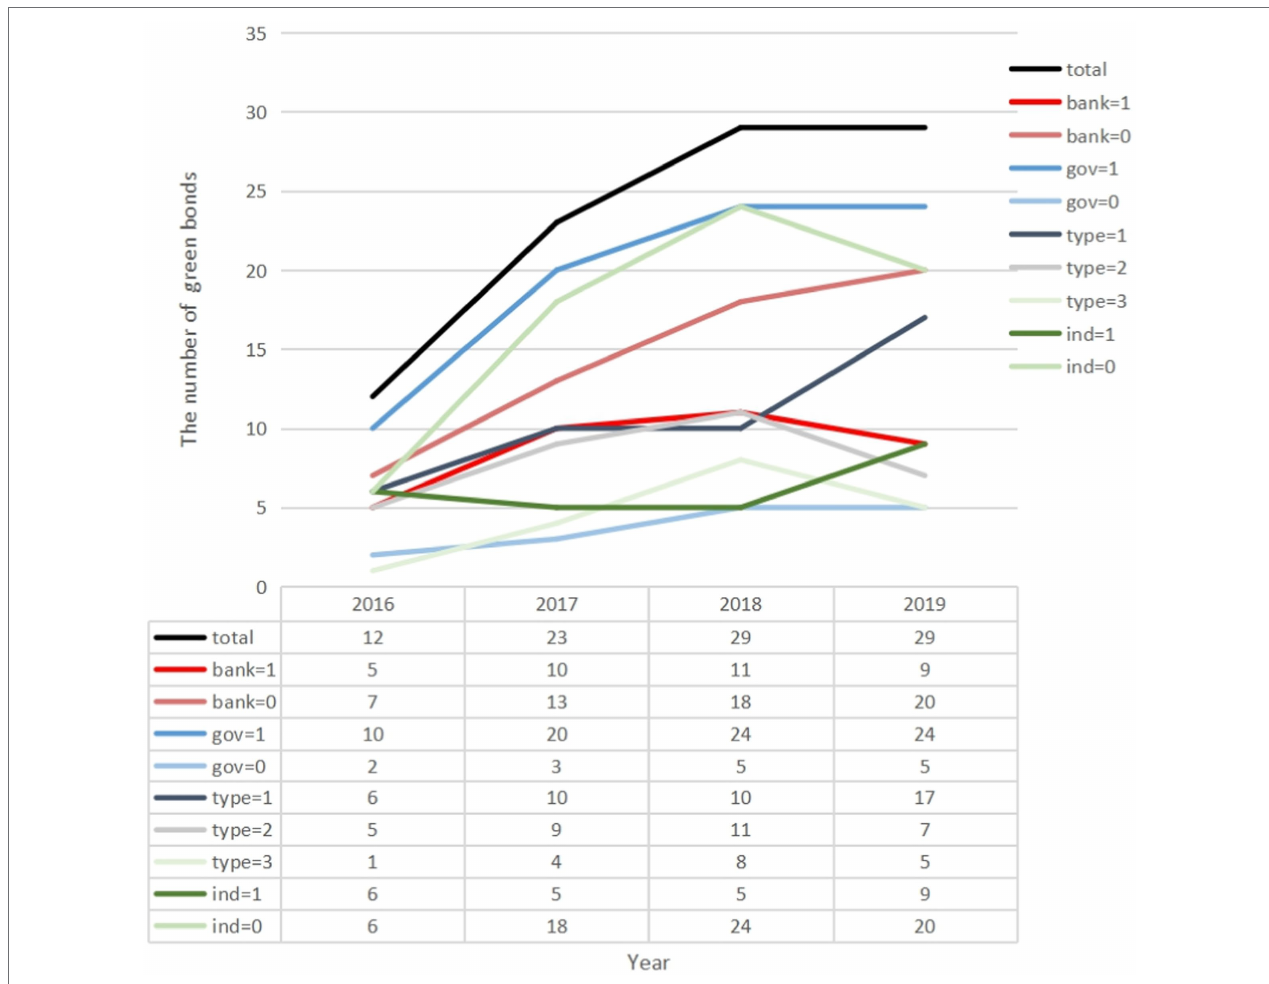
FIGURE 2 | Sample composition of firm types, industry types, and bond